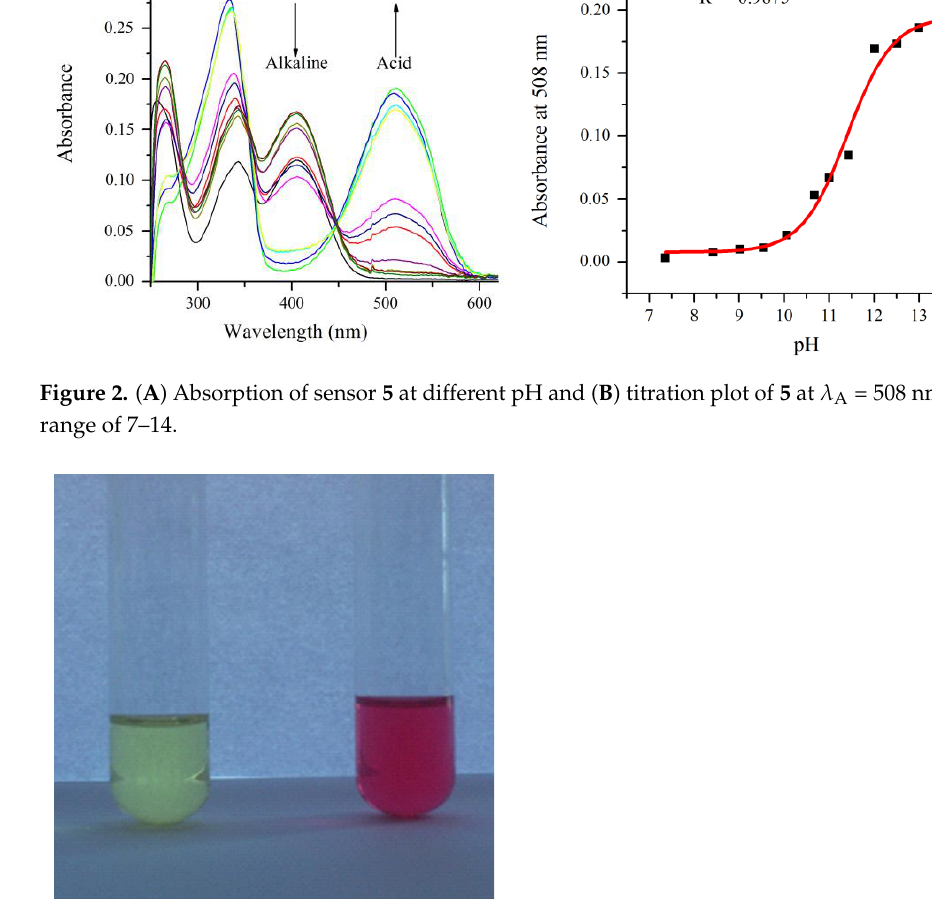
Figure 3. Colorimetric changes of 5 in the absence ( left ) and in the presence of NaOH ( right ). In a pH range ca. 2 – 7, as expected, Dyad 5 retained a weak absorbance at 508 nm due After excitation at 340 nm in the absorption maximum of the unsubstituted at C-4 position 1,8-naphthalimide part of the molecule, the system showed two emission bands at about 410 nm and at 504 nm, which was quenched upon transition from an acid to an alkaline environment (Figure 4A).